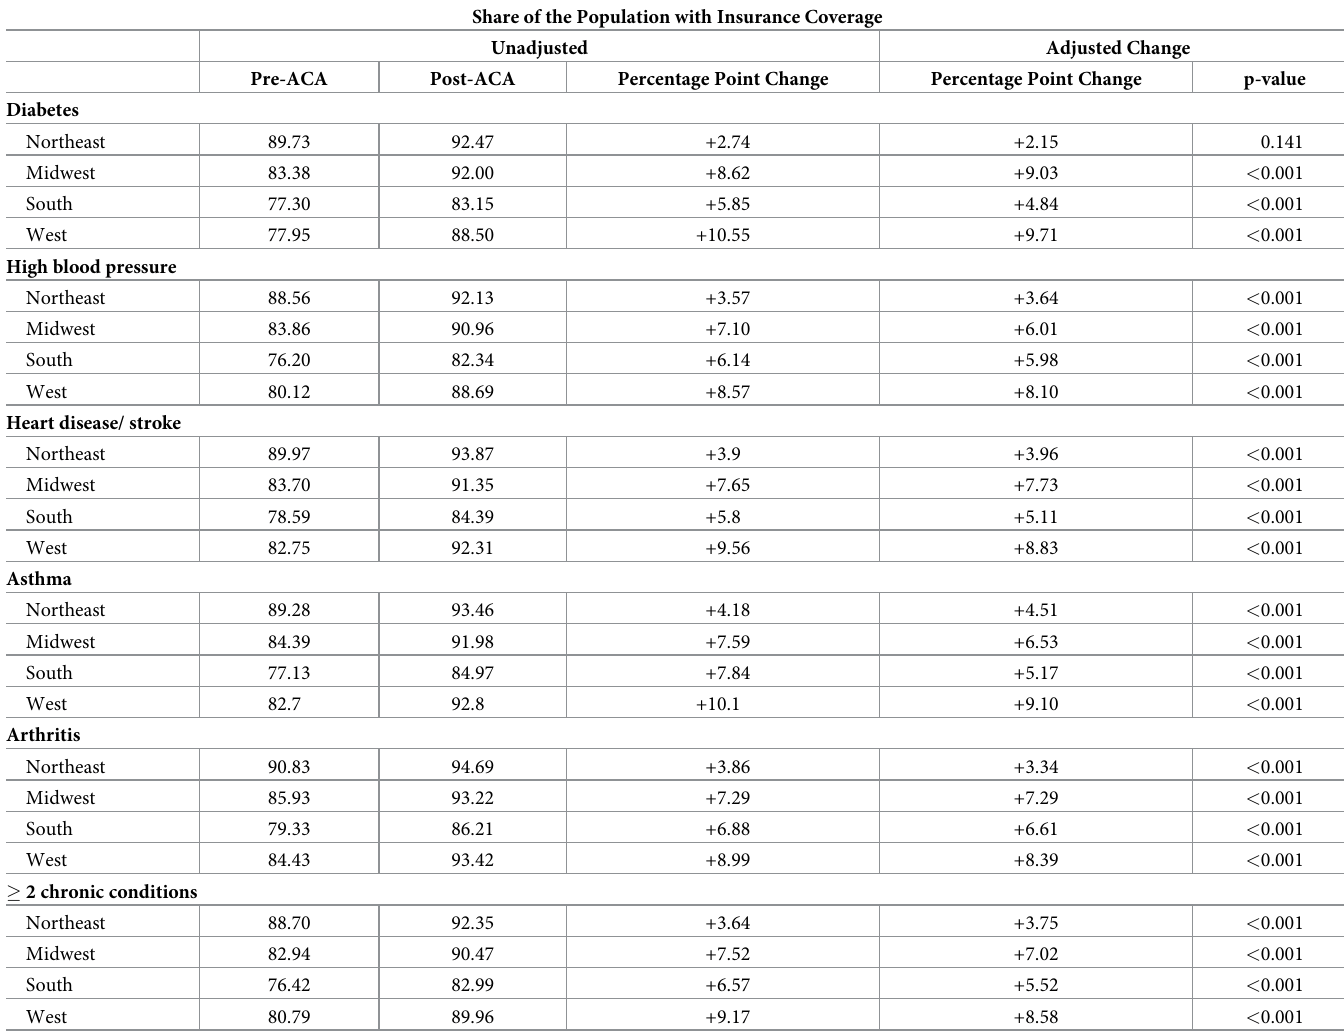
Table 2. The Impact of ACA on Insurance Status of Individuals Ages 18-64 with each select Chronic Condition by US Census Region, MEPS Survey Data 2010- 2017. Share of the Population with Insurance Coverage